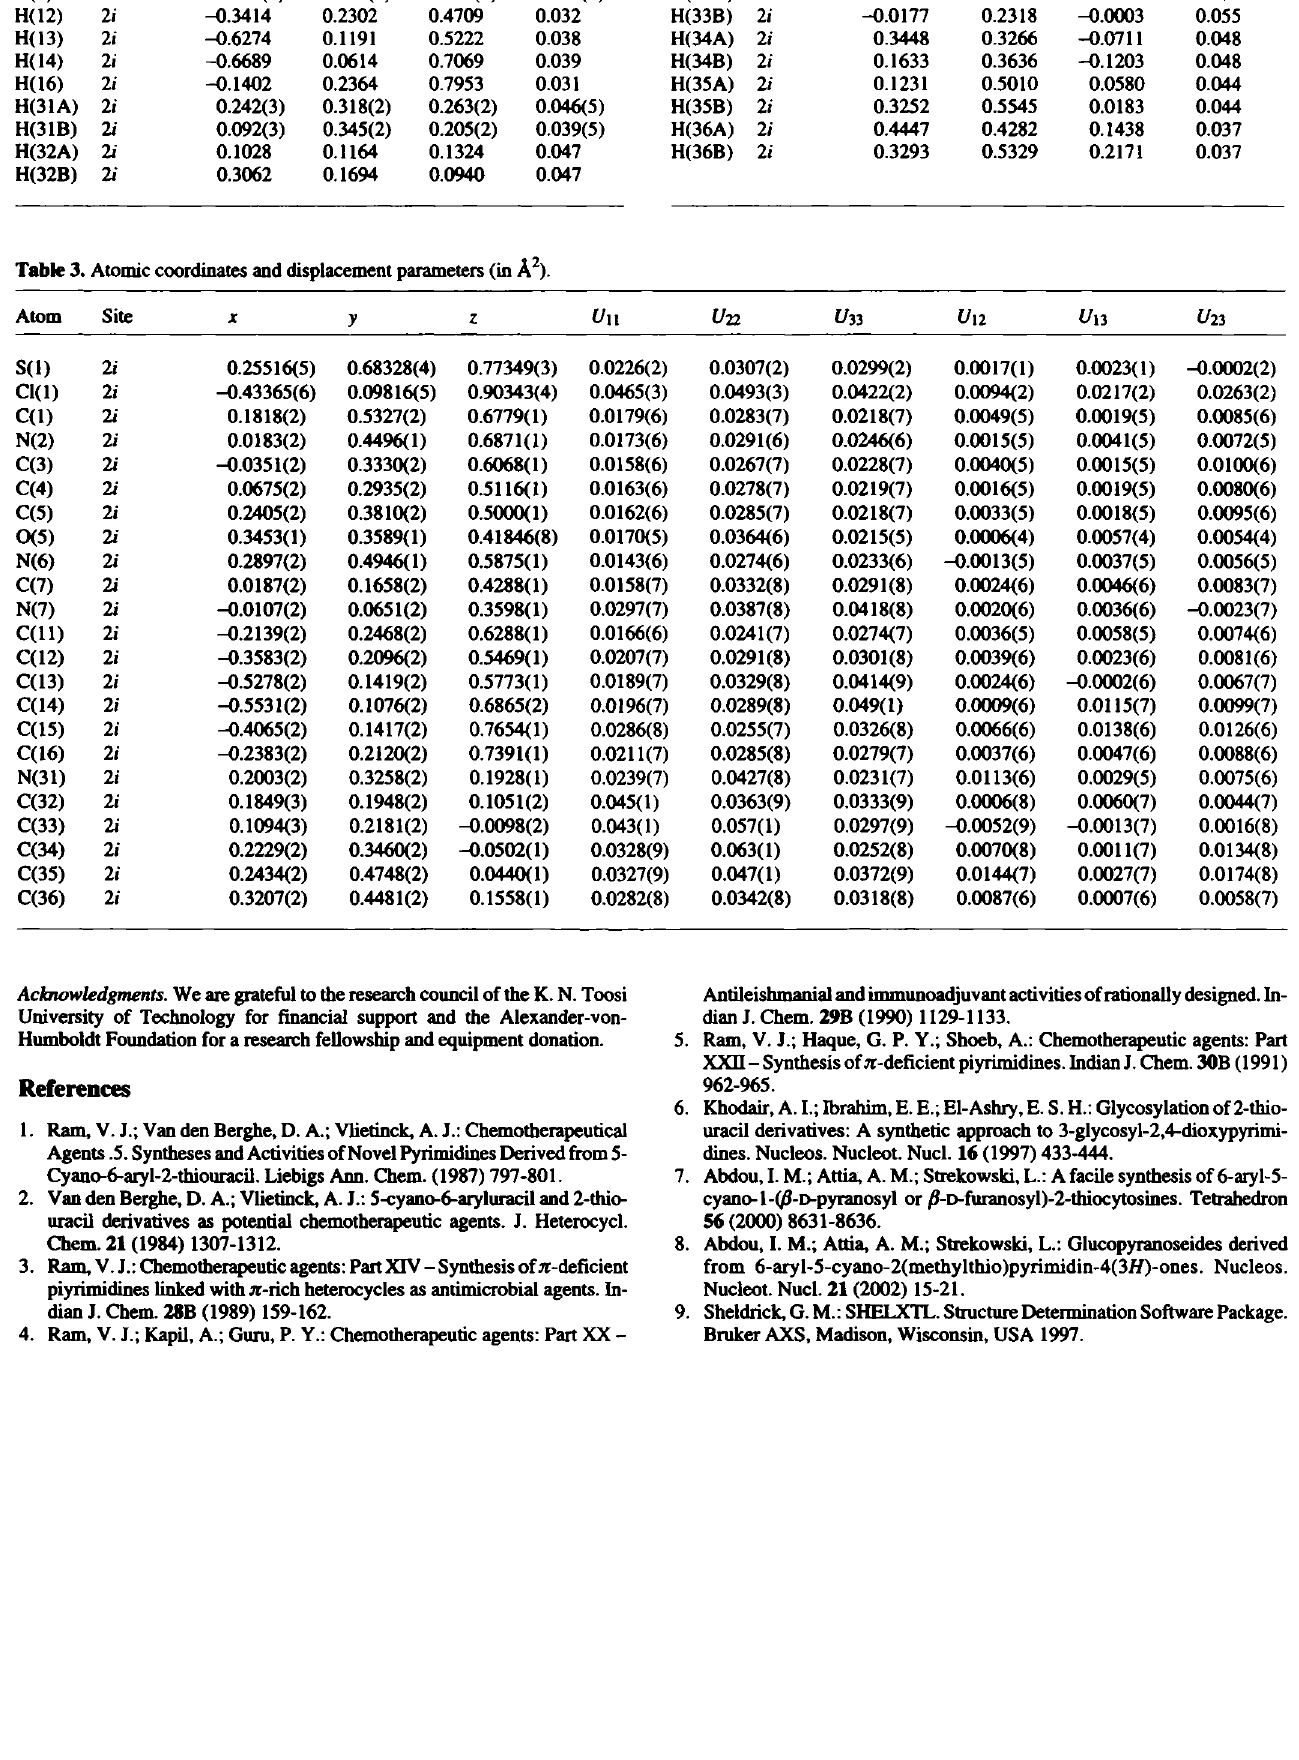
Table 2. Atomic coordinates and displacement parameters (in A 2 ).